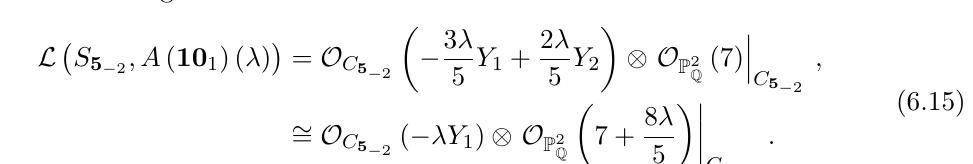
Table 7. Comparision of sections over B 3 = P 3 Q and their restriction to W = P 2 Q . by the sheaf cohomologies of the line